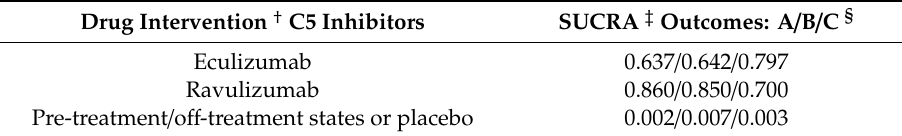
Pre-treatment / o ff -treatment states or